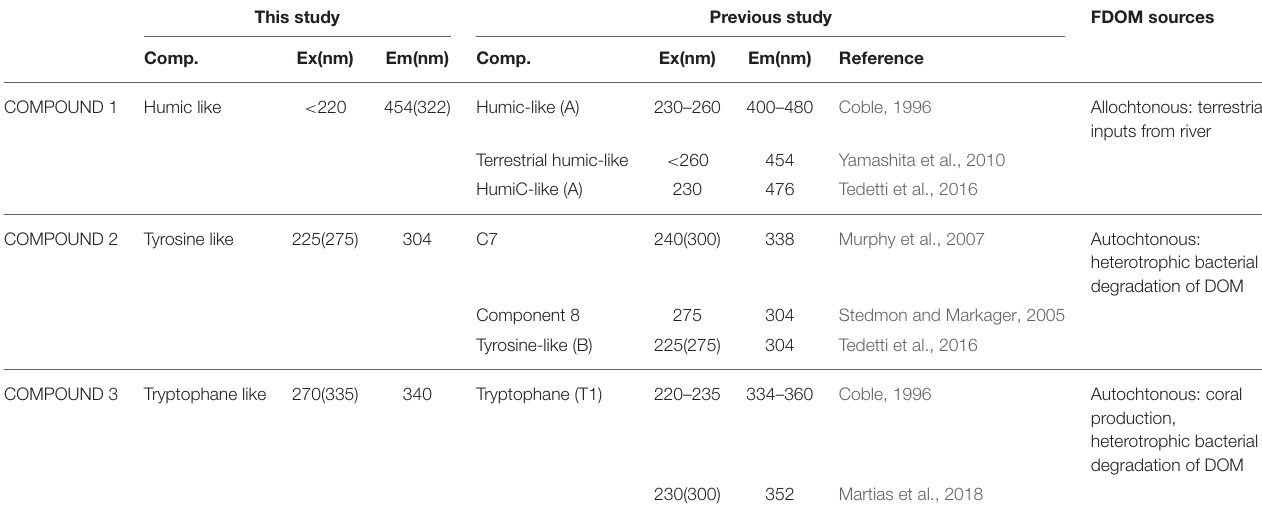
TABLE 3 | Excitation and Emission maxima (Ex/Em) of three CDOM fluorescent components validated by PARAFAC model and identification by comparison with the literature